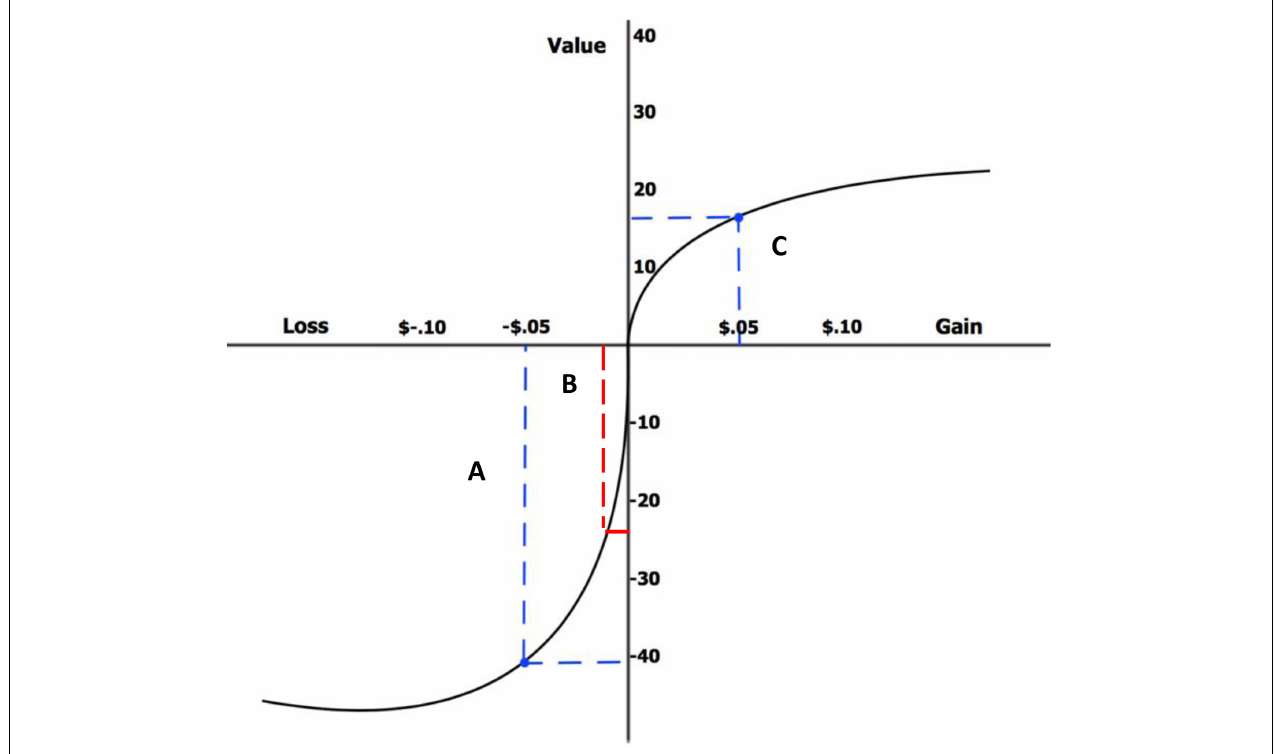
FIGURE 1 | S-curve value function passing through the reference point. Image source (Laurenrosenberger, with permission to use and transform for any purpose)